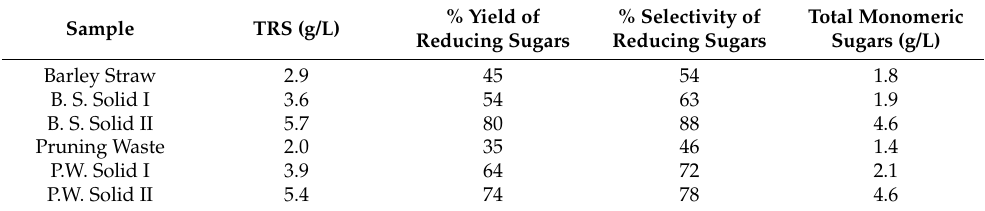
Table 6. Results of TRS measurements for the samples obtained after the acid hydrolysis